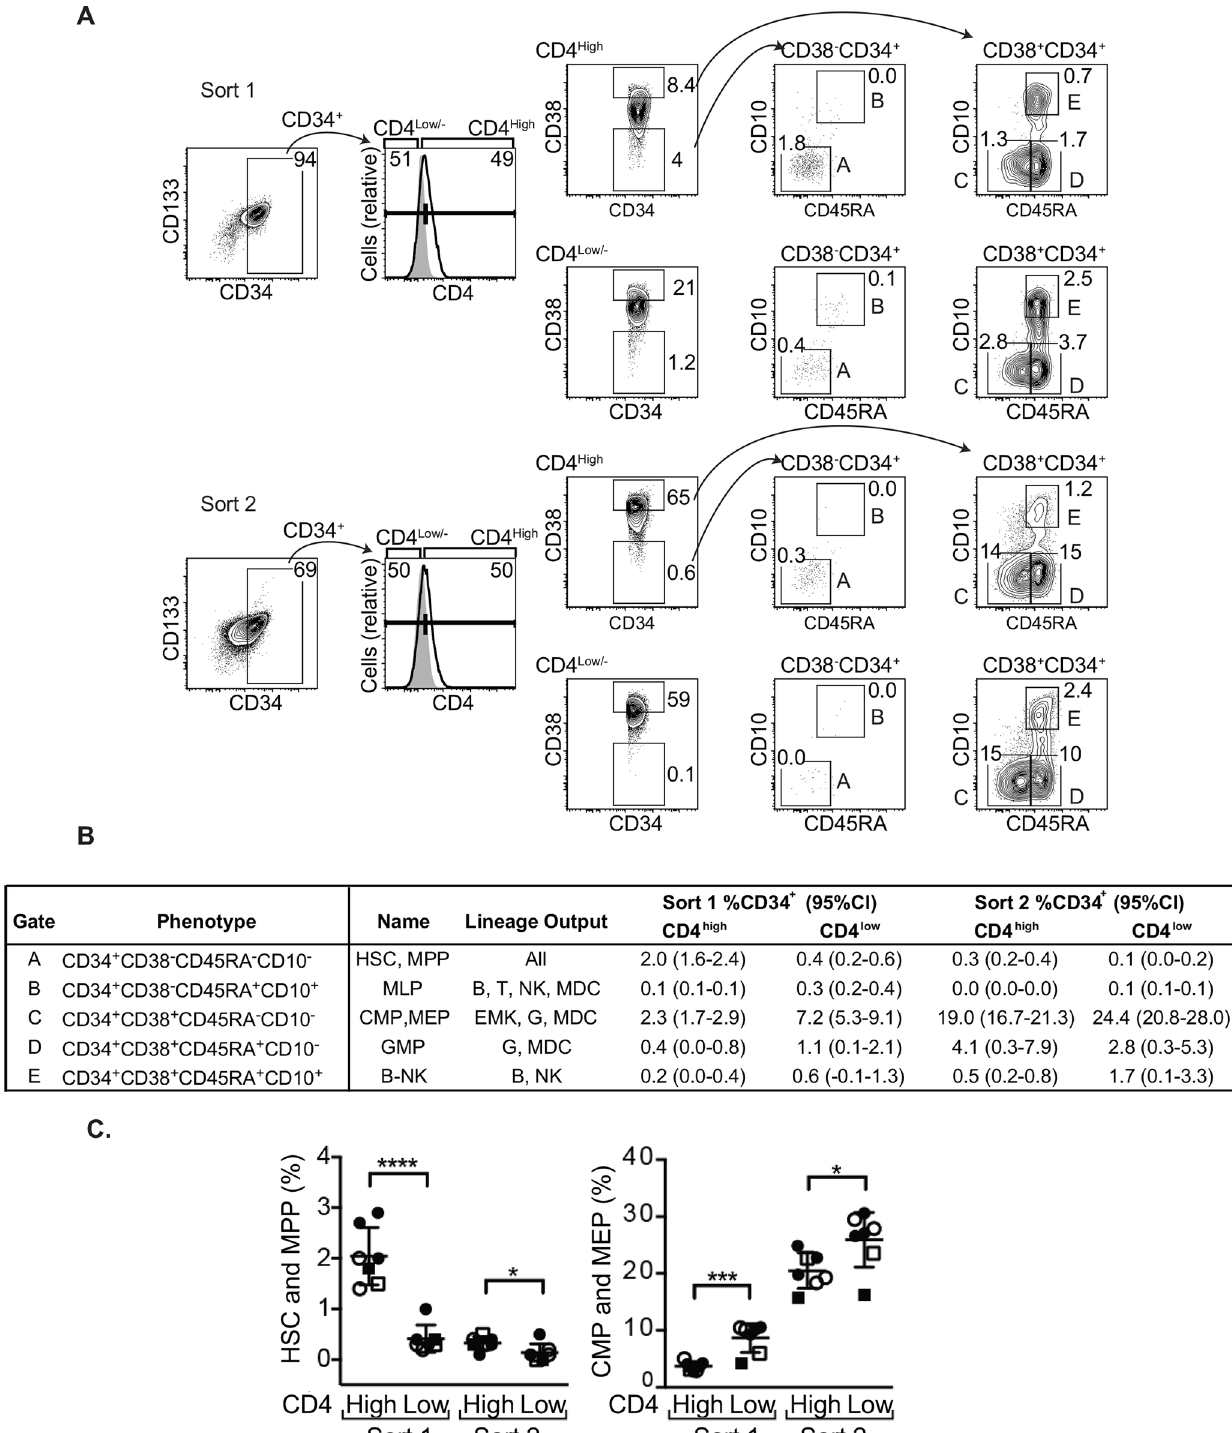
Fig 8. CD4 high HSPCs include progenitors with multi-lineage potential. A. Flow cytometric analysisof differentiation markers expressedon bone marrow HSPCs purifiedas describedin Fig 1A. For the two right-most panels,numbersindicate percentage of total CD34 + events in each sort falling into that gate. B. Summary table of frequenciesfor each phenotypic gate as shown in A. Lineageoutputs based upon Doulatov et al [9]. (Abbreviations: HSC, hematopoietic stem cell; MPP, multipotent progenitor; MLP, multilymphoid progenitor; CMP, common myeloid progenitor; MEP, megakaryocyte/erythrocyte progenitor; GMP, granulocyte/monocyte progenitor; B-NK, B and NK cell progenitor; MDC, macrophage and dendriticcell; EMK, erythroid and megakaryocyte) C. Summary graphsdepictingthe percentage of each subset of the total